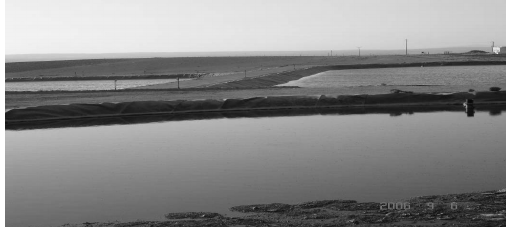
Figure 1. Al-Lajoun wastewater disposal